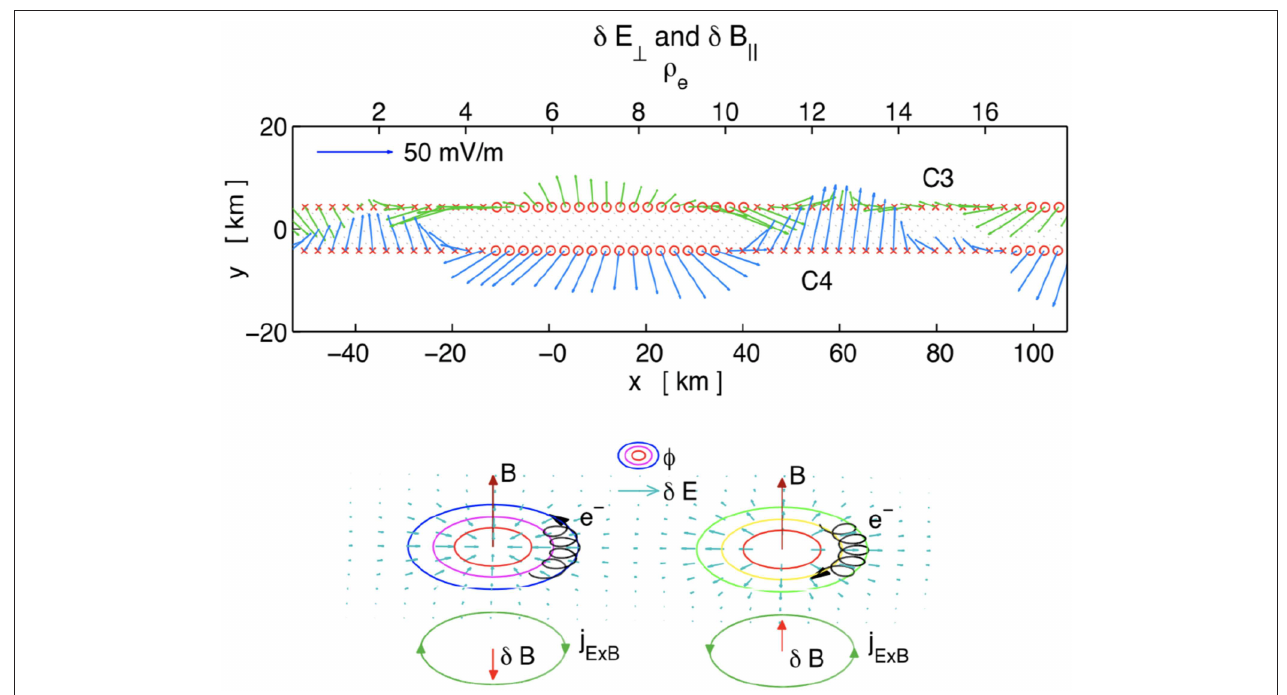
FIGURE 8 | Example of lower hybrid waves observed by two Cluster spacecraft (Norgren et al., 2012). The waves had significant transverse electric fields forming alternating converging and diverging structures associated with corresponding negative and positive potentials, respectively. The potential structures and electric fields are associated with vortex-like electron motion as illustrated in the